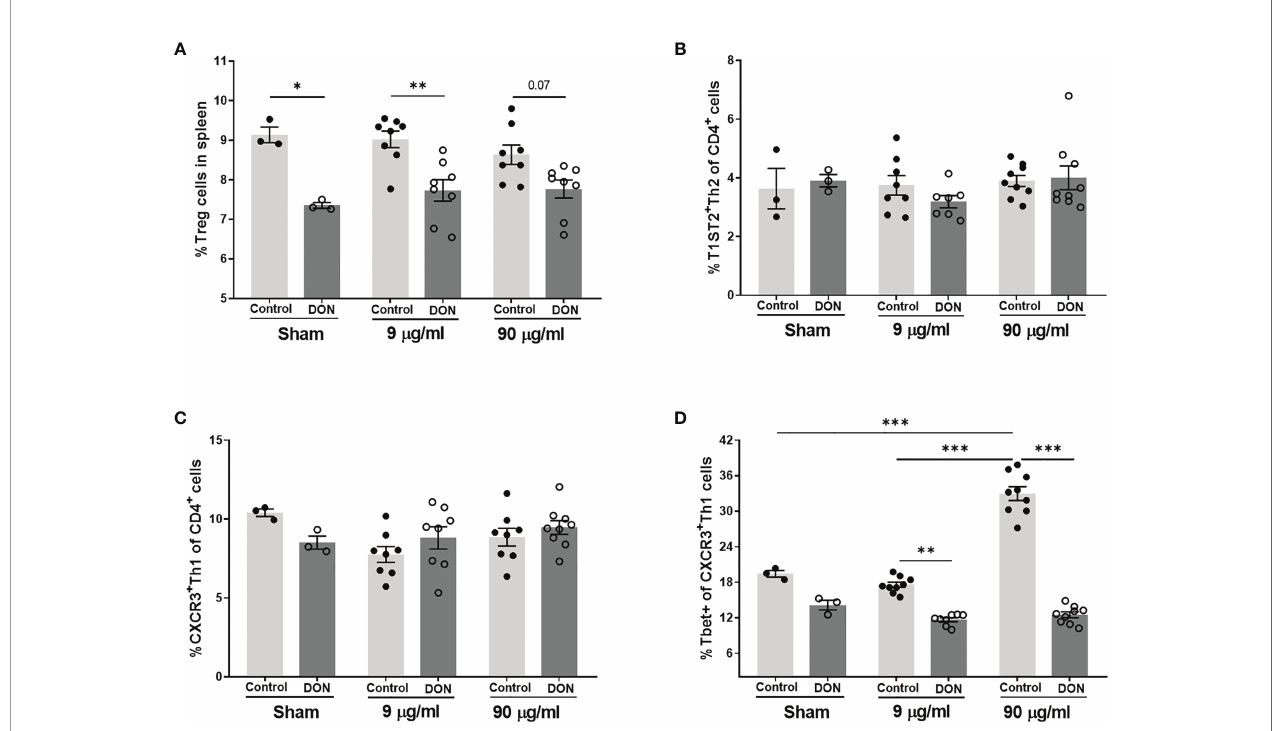
FIGURE 5 | Maternal deoxynivalenol (DON) exposure modulated the splenic T cell populations in the male offspring. Pregnant mice fed either a control or DON- contaminated diet (12.5 mg/kg) during pregnancy and lactation period. Male offspring received subcutaneous injections of either phosphate-buffered saline (PBS, sham) or In fl uvac (9 and 90 µg/mL) after weaning. 10 days after the second injection, male offspring were sacri fi ced and spleen samples were used for fl ow cytometric analysis of T cell subpopulations. Percentages of (A) CD25 + Foxp3 + regulatory (Treg) cells, (B) T1ST2 + Th2 cells; (C) CXCR3 + Th1 cells, and (D) Tbet + cells out of CXCR + Th1 cells, out of live CD4 + cells in spleen; Data are presented as mean ± SEM. *p < 0.05, **p < 0.01 and ***p < 0.001 indicate statistical differences. [FOXP3 (fork-head box P3), CXCR3 (C-X-C Motif Chemokine Receptor 3), T-bet (T-box expressed in T cells,